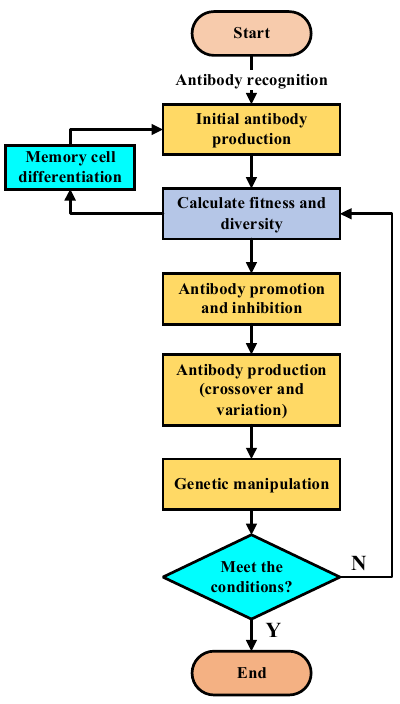
Figure 4. Immune algorithm flowchart.